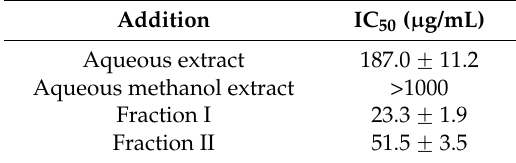
Table 2. IC 50 values of extracts and fractions from Erythrina crista-galli on the growth of MCF-7